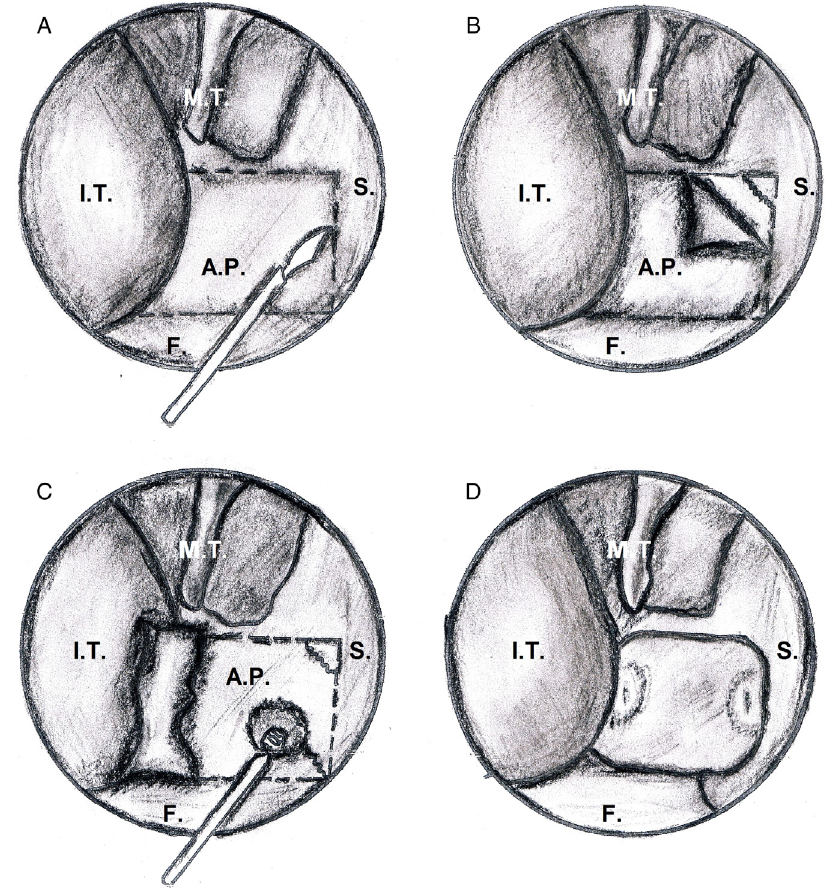
Figure 4 Main surgical steps of endoscopic choanoplasty technique from right nasal cavity: I.T., inferior turbinate; M.T., middle turbinate; S, septum, A.P., atretic plate; F, nasal floor. (Fig. 4B and Fig. 5A). This step can be completed by the upward dislocation of the inferior turbinate in order to improve the exposure of the surgical field. 3. Perforation of the CA is performed at the level of its inferomedial portion and subsequent complete removal of the atretic plate together with the mucosa of the